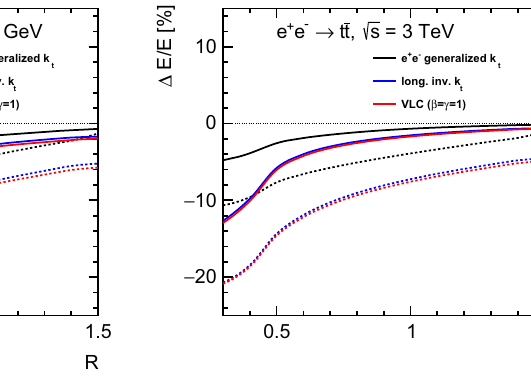
Fig. 5 Jet energy correction as a function of the jet radius parameter R √ s = 250GeV(leftpanel)and e + e − → t ¯ t in e + e − → q ¯ q productionat √ s = 3TeV(rightpanel).Thecontinuouslinecorresponds productionat to the median relative correction, the dashed line to the mean. Results